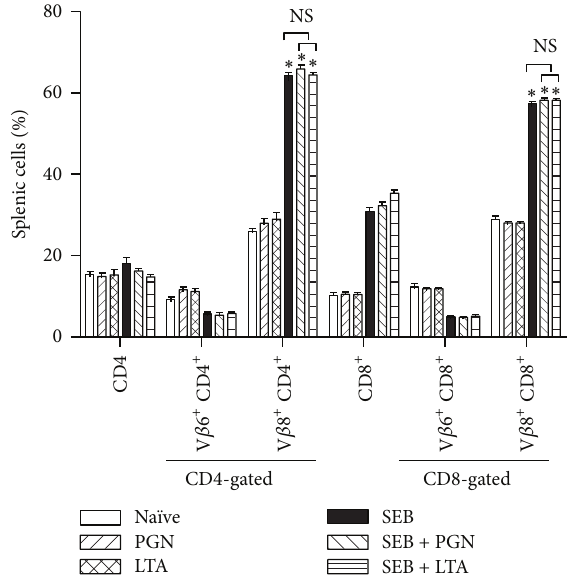
Figure 5: Effect of S. aureus -derived PAMPs on SEB-induced T cell expansion in vivo . HLA-DR3 transgenic mice were challenged with staphylococcal enterotoxin B (SEB) alone (10 𝜇 g), staphylococcal peptidoglycan (PGN) alone (50 𝜇 g), or lipoteichoic acid (LTA, 50 𝜇 g), SEB with PGN or SEB with LTA. Animals were killed 3 days later and distribution of T cells expressing TCR V 𝛽 families were determined by flow cytometry. Mean ± SE from 5–8 mice in each group. ∗ 𝑃 < 0.05 compared to na¨ıve mice. 𝑝 = NS between SEB versus SEB + PGN, SEB versus SEB + LTA, and SEB + LTA versus SEB +